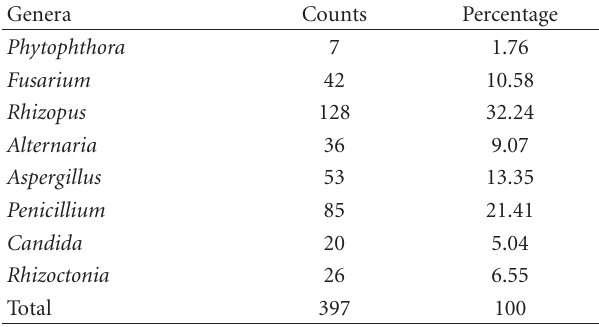
Table 2: Fungi and yeast genera identified on isolates from lesions of wilted plants with root rot of chilli pepper collected in the northern area of Aguascalientes,